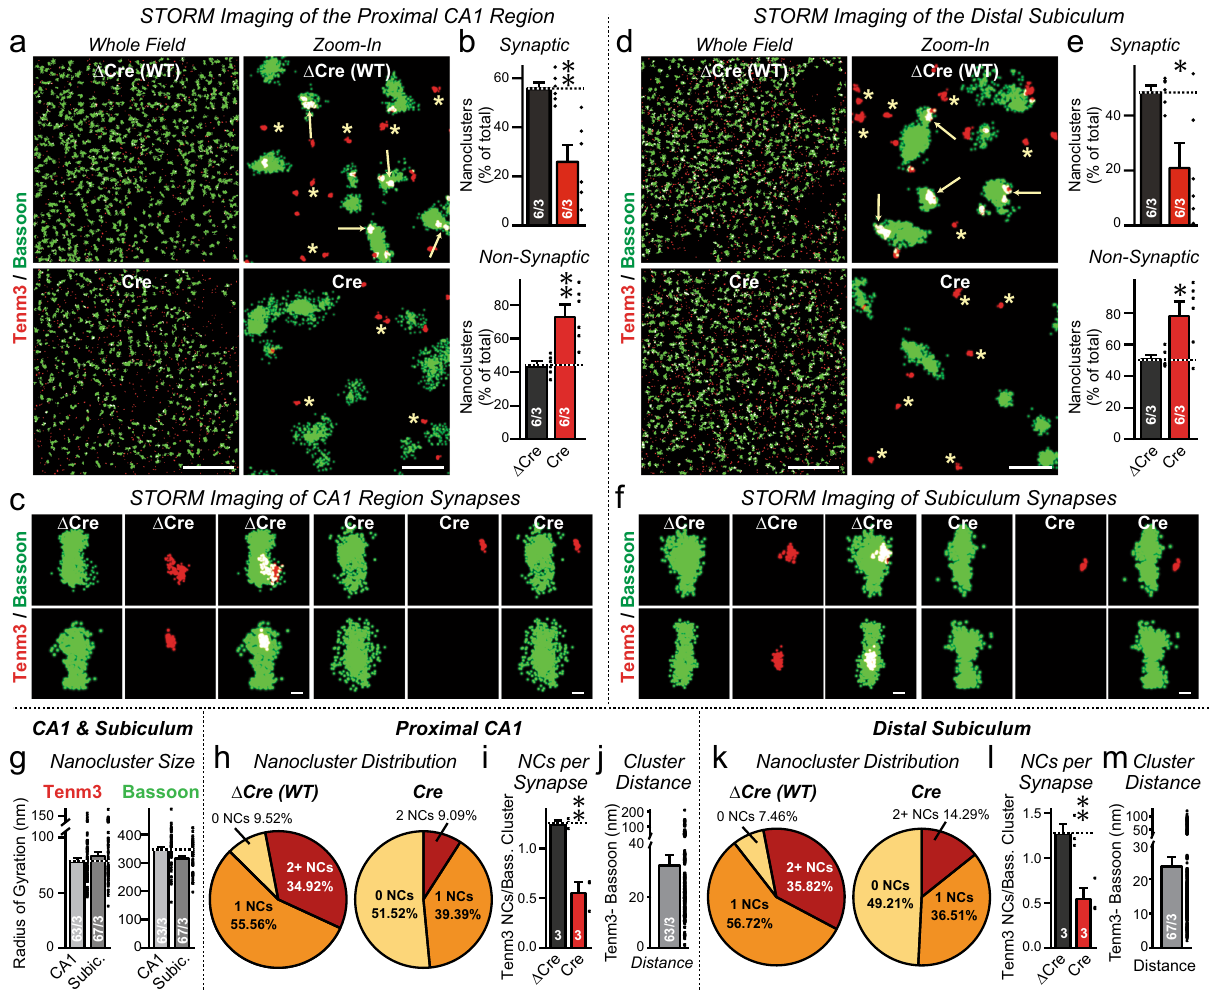
Fig. 2 Super-resolution STORM imaging reveals synaptic Tenm3 nanoclusters in the proximal CA1 and the distal subiculum that are adjacent to presynaptic active zones visualized with antibodies to Bassoon. a Representative images of Tenm3 nanoclusters (red) and presynaptic Bassoon macroclusters (green) show that the majority of Tenm3 nanoclusters in the proximal CA1 region are localized close to presynaptic active zones. Left images show overviews; right images, zoom-ins, in the whole fi eld (left) and zoon-in fi eld (right) at proximal CA1. Mice were infected with AAVs at P0 and analyzed at P13 (arrows = synaptic Tenm3 nanoclusters co-localized with Bassoon macroclusters; asterisks = non-synaptic Tenm3 nanoclusters that are >80 nm separated from presynaptic Bassoon macroclusters). b The Tenm3 deletion suppresses synaptic Tenm3 nanoclusters in the proximal CA1 region. Summary graphs show the percentage of Tenm3 nanoclusters that are synaptic (top) or non-synaptic (bottom) in control-infected (black) or Cre- expressing AAVs Tenm3 cKO mice (red). c Representative images of individual synapses in the proximal CA1 containing Tenm3 nanoclusters in mice without ( Δ Cre, left) and with deletion of Tenm3 in the MEC (Cre, right). d – f Same as a – c , except that brain sections were analyzed from distal subiculum. g Tenm3 nanoclusters occupy approximately 6% of the presynaptic active zone. Summary graphs depict the radius of Tenm3 nanoclusters (left) and Bassoon macroclusters (right) in the proximal CA1 and distal subiculum. h Most (>90%) presynaptic active zones visualized as Bassoon macroclusters contain 1 – 2 Tenm3 nanoclusters in WT synapses in the proximal CA1 region. i Summary graph of the average number of nanoclusters per Bassoon-positive